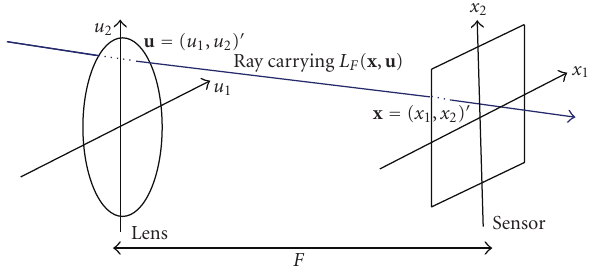
Figure 1: Two-plane parameterization of the